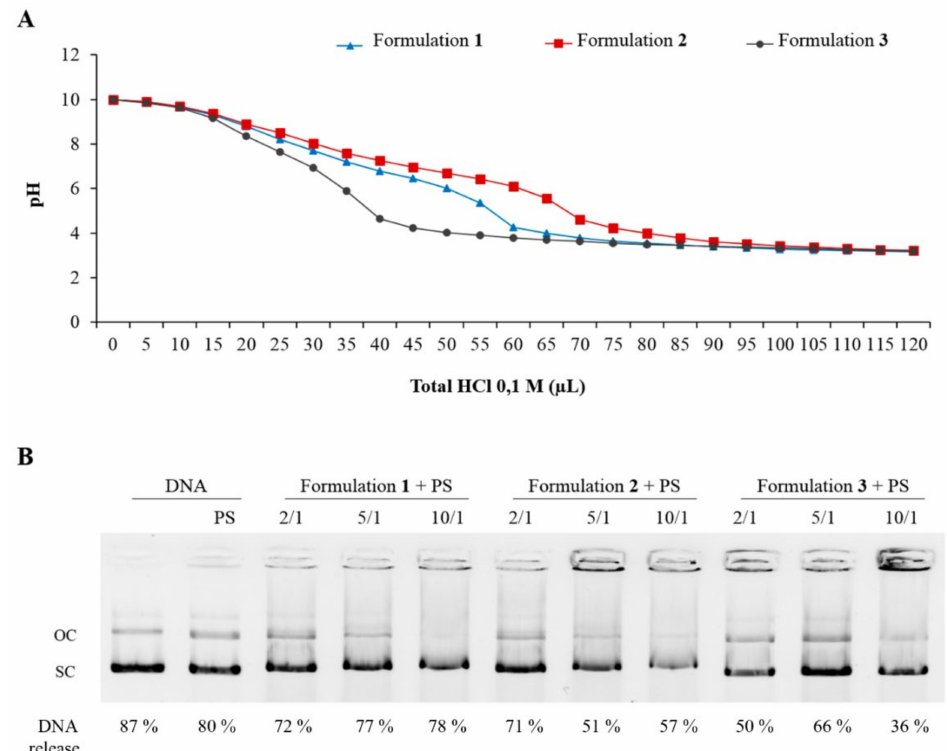
Figure 7. Buffer capacity and endosomal escape evaluation. ( A ) Analysis of pH buffering capacity of niosomes based on formulations 1 (blue line, triangles), 2 (red line, squares) and 3 (grey line, dots). ( B ) DNA release profiles in agarose gel electrophoresis assay of nioplexes based on niosome formulations 1 , 2 and 3 at cationic lipid/DNA mass ratios at 2/1, 5/1 and 10/1 from phosphatidylserine (PS) micelles. OC: open circular. SC: